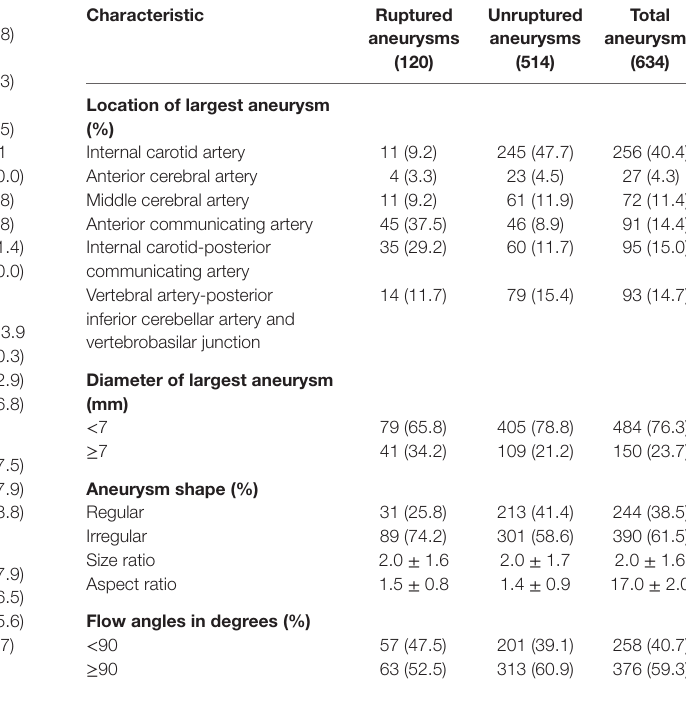
TaBle 2 | Aneurysmal characteristics.